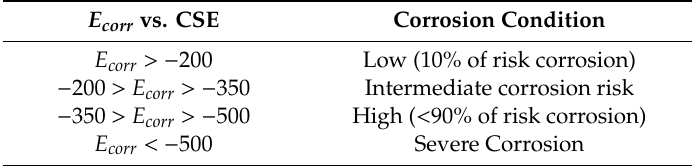
Table 7. The measured half-cell corrosion potential ( E corr ) versus a Cu / CuSO 4 in reinforcement concrete [81,82].